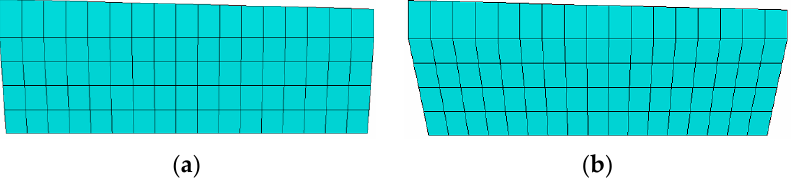
Figure 18. Finite element model of TLVT and ILVT bearing block. ( a ) TLVT elastic support block. ( b ) ILVT elastic support block.